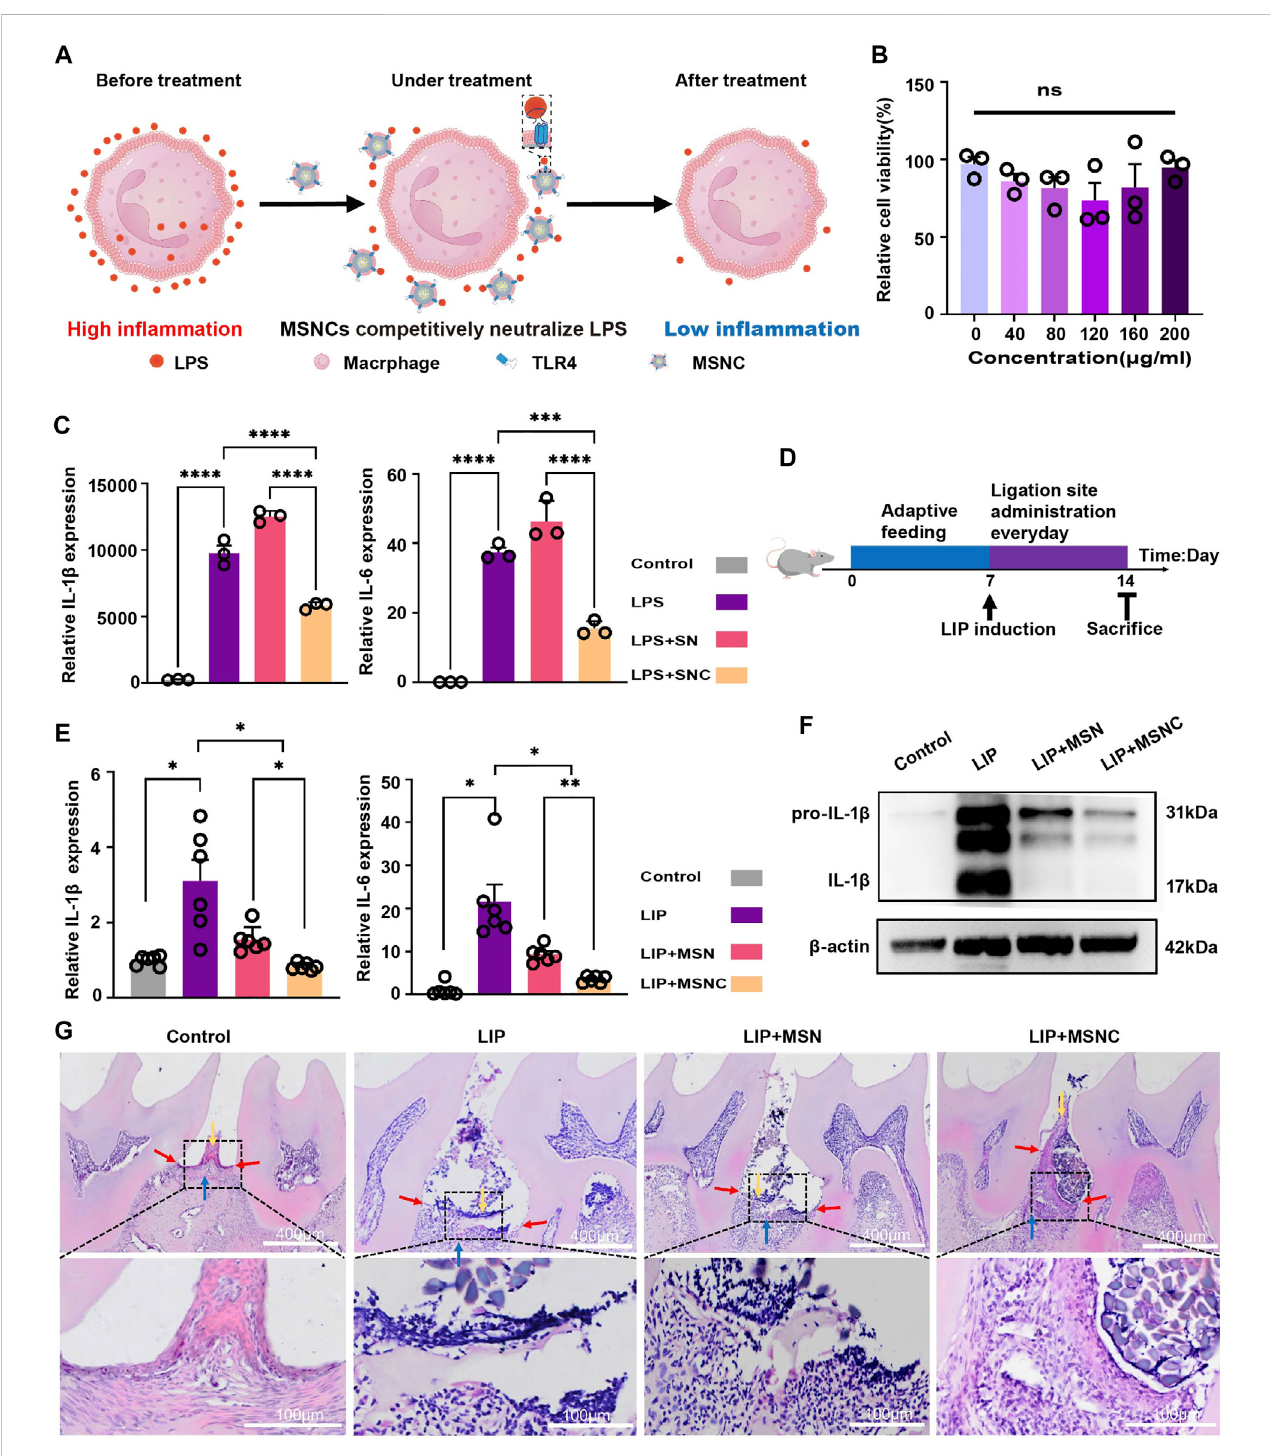
FIGURE 5 Anti-in fl ammatory effects of functioned cell membrane coated silk fi broin nanoparticles loaded with minocycline hydrochloride in vitro and vivo. (A) SchematicillustrationofMSNCsimmunoregulatoryeffects invitro . (B) CCK-8ofSNCs. (C) RT-PCRforSNCsneutralizationofLPS. (D) Schematicillustrationof animalexperiments. (E) RT-PCRofMSNCSwithreducingperiodontaltissuein fl ammation. (F) WBofMSNCswithreducingperiodontaltissuein fl ammation. (G) HE staining of MSNCs with reducing periodontal tissue in fl ammation. The yellow arrow represents the position of the gingival epithelial peg, the red arrowrepresentsthepositionofthejunctionalepitheliumandthebluearrowrepresentsthepositionofthealveolarbone.Dataarepresentedasmeans±SEM, ns p > 0.5, * p < 0.05, ** p < 0.01, *** p < 0.001, and **** p < 0.0001; by one-way analysis of variance (ANOVA) with Tukey ’ s post hoc test (B,C, E)